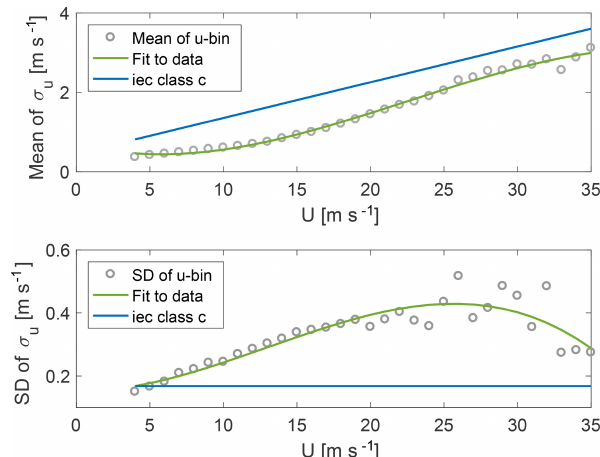
Figure 4. The mean and standard deviation of σ u as a function of wind speed at 100m for raw data (not detrended or filtered). The blue curves show the IEC expressions, the grey dots show the mea- sured values, and the green curves show a polynomial fit to the mea-